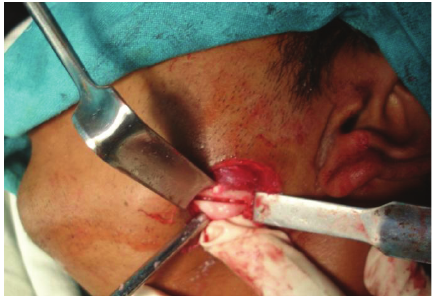
Figure 7: Intraoperative view.